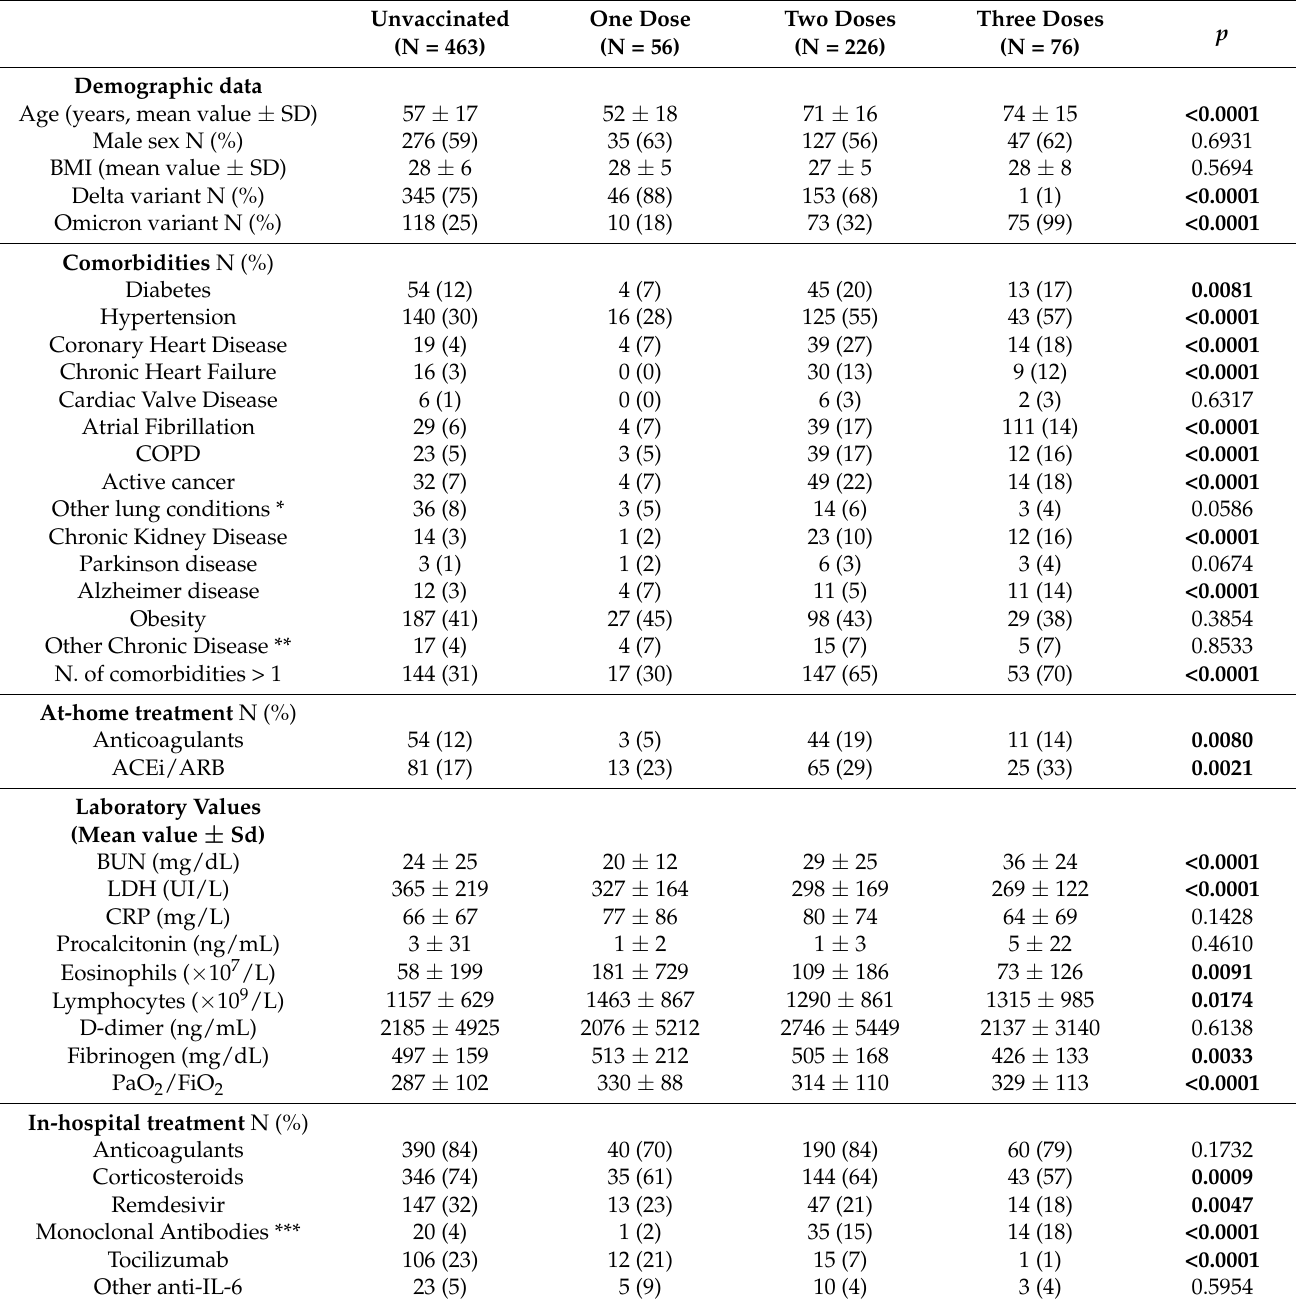
Table 3. COVID-19, patients’ demographic, comorbidities, laboratory, and outcomes